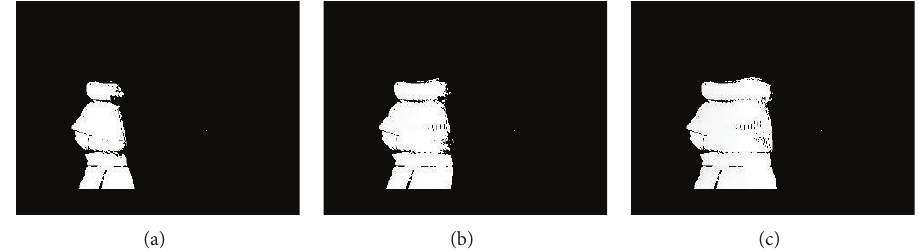
Figure 4: (a) MHI of 5 frames of single walking person; (b) MHI of 10 frames of single walking person; (c) MHI of 15 frames of single walking person.